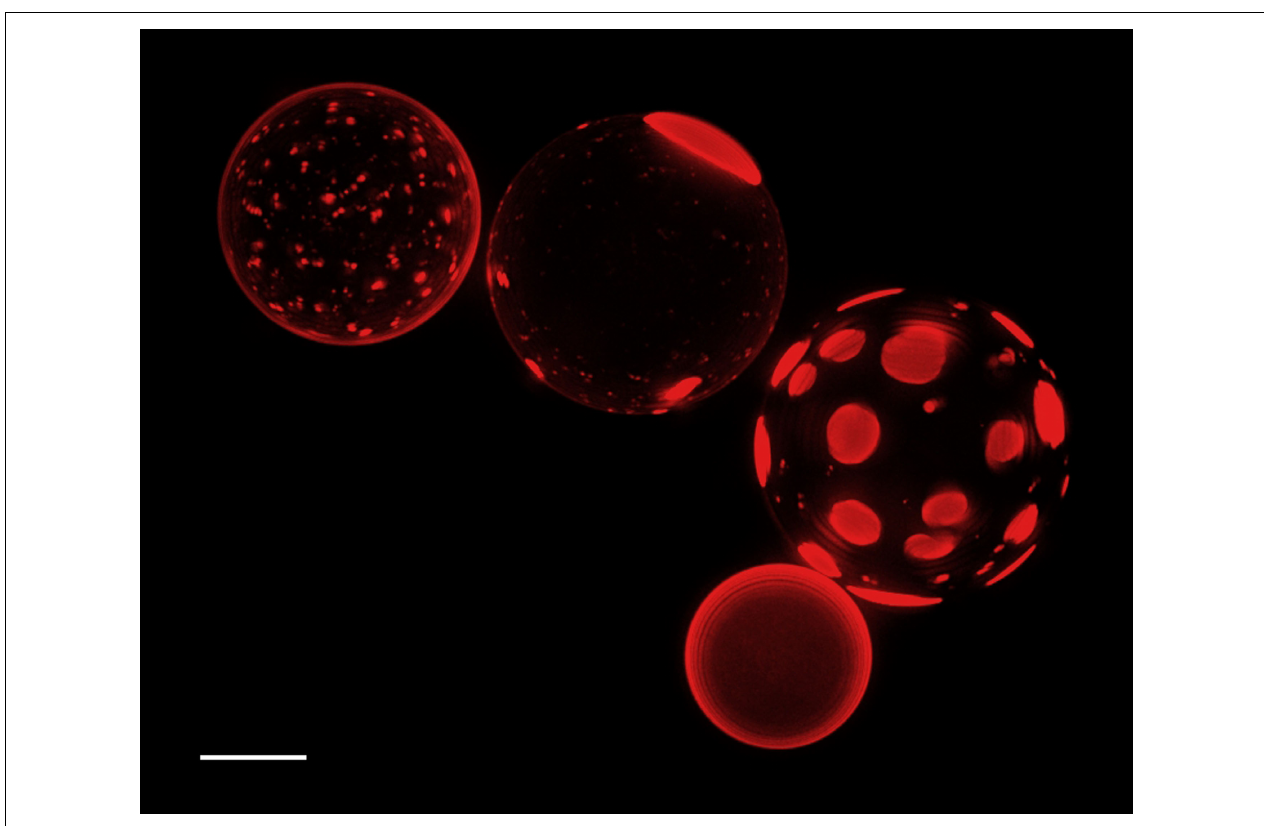
outside), are shown. No phase separation was observed prior to sample dilution in MilliQ water. 0.5mol% Rho-DPPE was used to label the L d phase. Scale bar: 10 μ